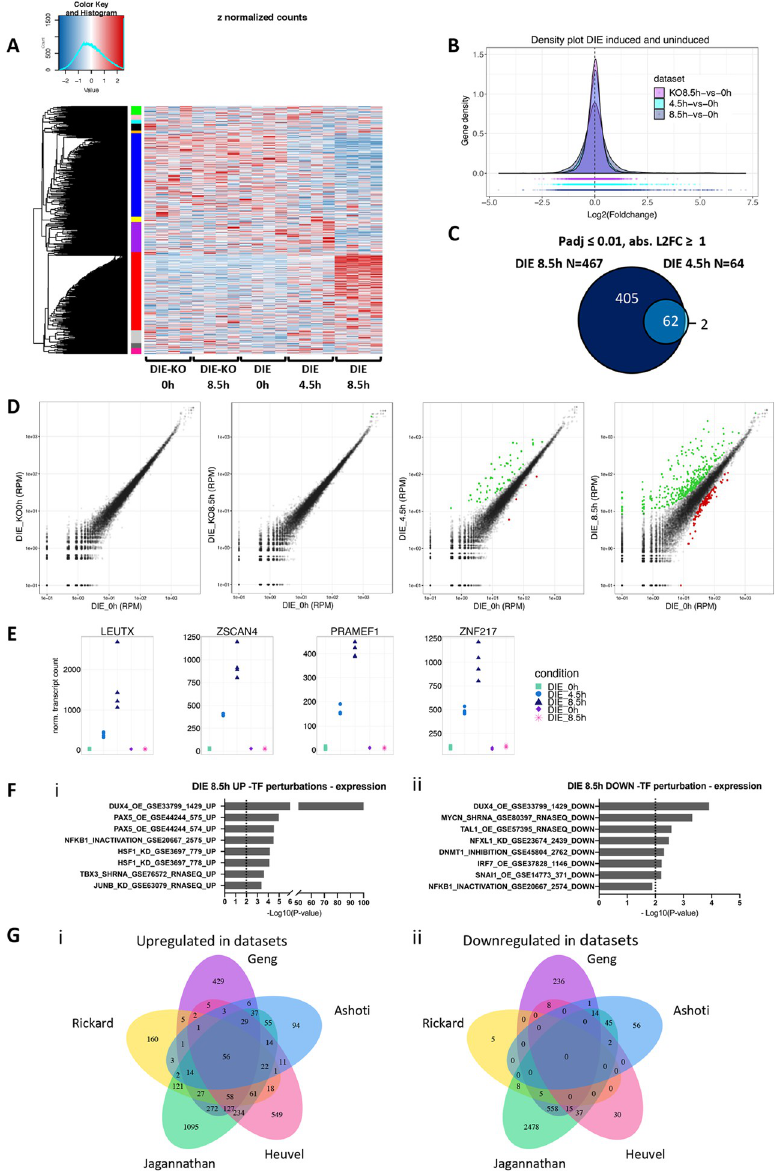
Fig 2. RNA-sequencing data reveals differentially expressed genes upon DUX4 expression. (A) Heatmap showing differentially expressed genes between DIE cells and DIE-KO (knockout for DUX4) cells, untreated or treated with doxycycline (1000ng/ml) for 4.5h or 8.5h, with gene clusters (color-coded) on the y-axis, and samples on the x-axis. (B) Gene density plot demonstrating the effects of DUX4 expression on the transcriptome of the DIE cell line. Doxycycline addition (1000ng/ml) for 4.5h or 8.5h results in an increase of differentially expressed genes compared to uninduced DIE cells, as indicated by the bell shape widening and shortening. This effect was not seen doxycycline-treated DIE-KO cells. (C) Venn diagram showing the overlap and the number of differentially expressed genes after 4.5h and 8.5h of doxycycline addition (1000ng/ml) (adjusted P-value � 0.01, and absolute Log2FC � 1). (D) Scatter plots of gene expression (RPM: Reads per million) of doxycycline-treated (1000ng/ml) DIE cells versus untreated DIE cells. The left two panels represent uninduced DIE cells (DIE_0h) on the x-axis versus doxycycline-treated or untreated DIE-KO samples (KO_0h and KO_8.5h) on the y-axis and show that addition of doxycycline has no effect on gene expression in DIE-KO cells. The right two panels compare the doxycycline-treated DIE cells with untreated DIE samples (4.5h and 8.5h). Green and red points represent the differentially expressed genes with an adjusted P- value � 0.01, and absolute Log2FC � 1. Green points represent upregulated genes, and the red points represent downregulated genes. (E) Count plots showing UMI and between sample normalized transcript counts of 4 known DUX4 targets genes: LEUTX, ZSCAN4, PRAMEF1 and ZNF217, in uninduced and doxycycline-treated